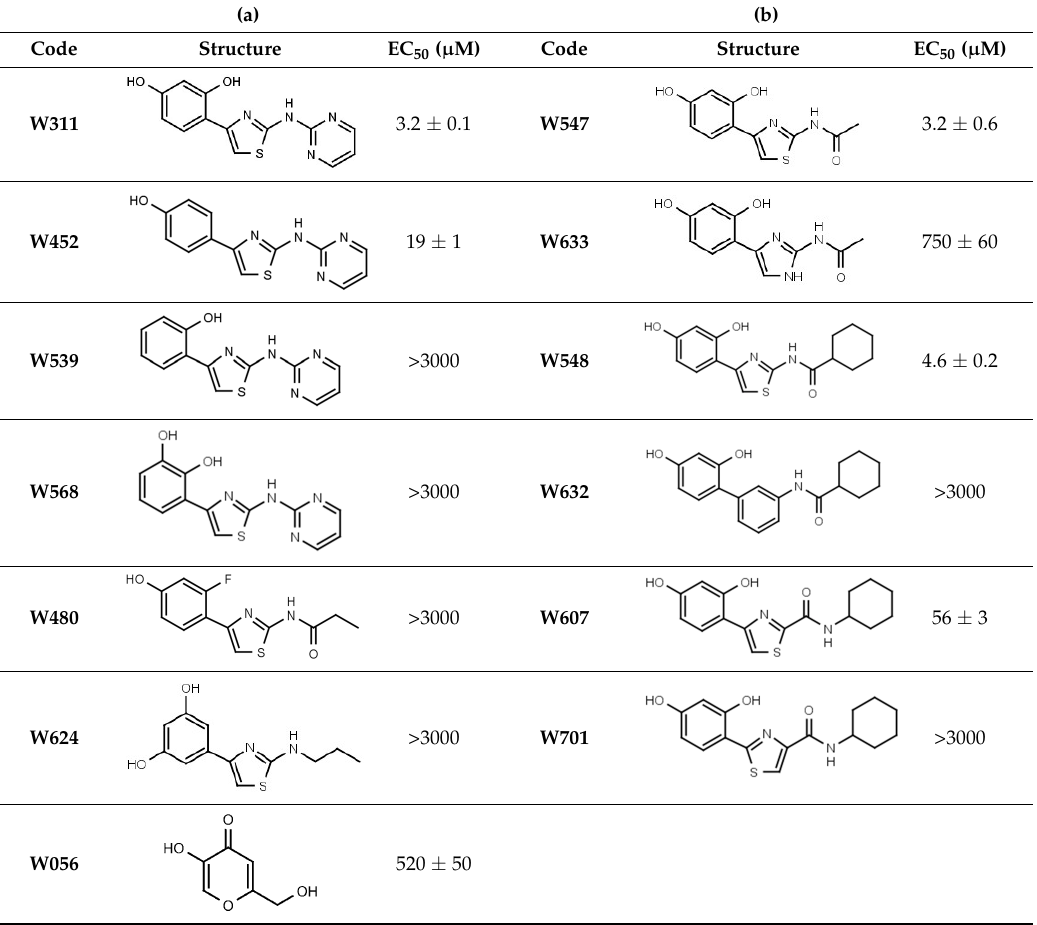
Table 1. Inhibitory activities (as EC 50 ) of thiazolyl resorcinols inhibitors with modified rings. ( a ) Influence of modifications of the resorcinol ring; and ( b ) effects of replacement or modification of the aminothiazole moiety. The EC 50 for kojic acid (W056) is shown for comparison.